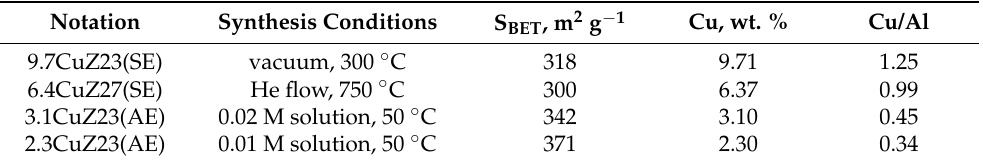
Table 2. Notations and some characteristics of the Cu/ZSM-5